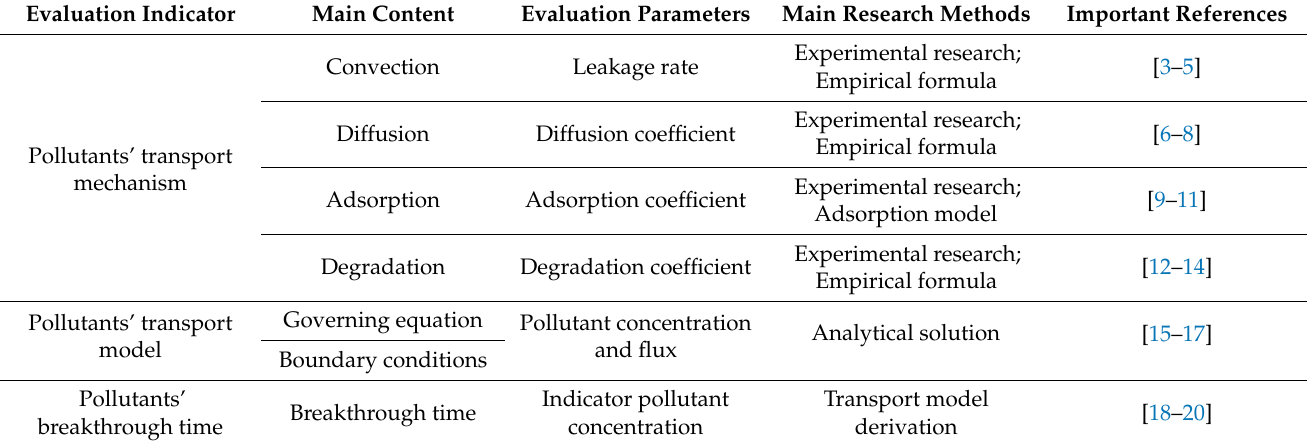
Table 1. Key evaluation indicators and research contents.